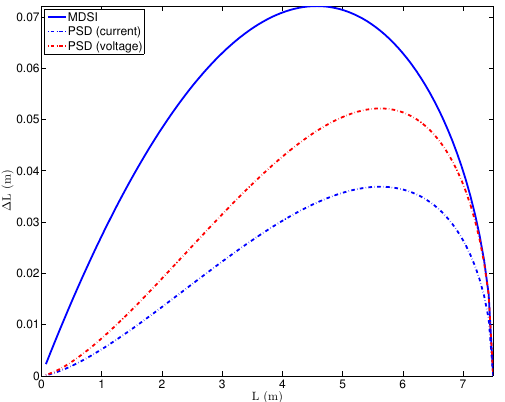
Figure 9. Distance error due to shot noise for the different ToF techniques without background noise. In the pulsed ToF techniques, T was set to 50 µ s (1000 T